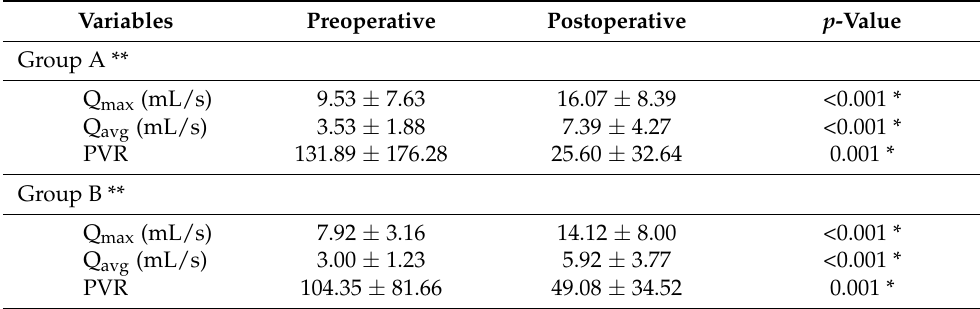
Table 4. Uroflowmetry in different prostate volume.